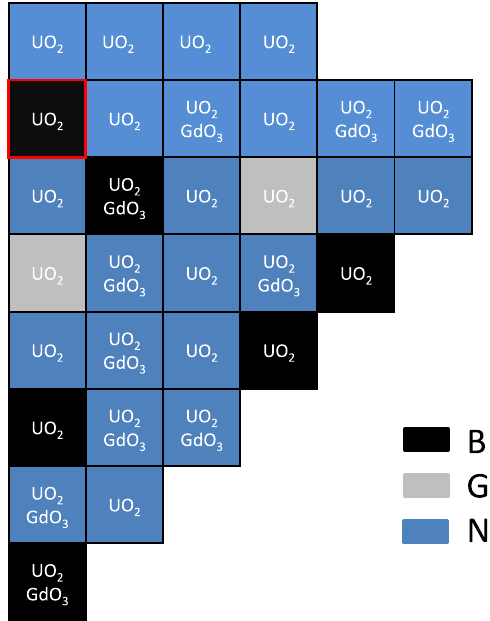
Fig. 2. PWR 1 / 8 core geometry and characteristic dimensions. B indicates assemblies with black control rods, G with grey con- trol rods and N with no control rods. The ejected control rod location is highlighted with red